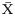
Ramp-up and holdover times.
(a) Ramp-up times (X¯ ± s) are reduced (*p = 0.018) and holdover times (X¯ ± s) show no change with the addition of sodium chloride to the magnesium-iron fuel pack. (n = 3) (b) In contrast, the addition of copper (II) chloride does not significantly affect ramp-up, but significantly reduces holdover (**p = 0.005). (n = 3) † indicates identical data points.